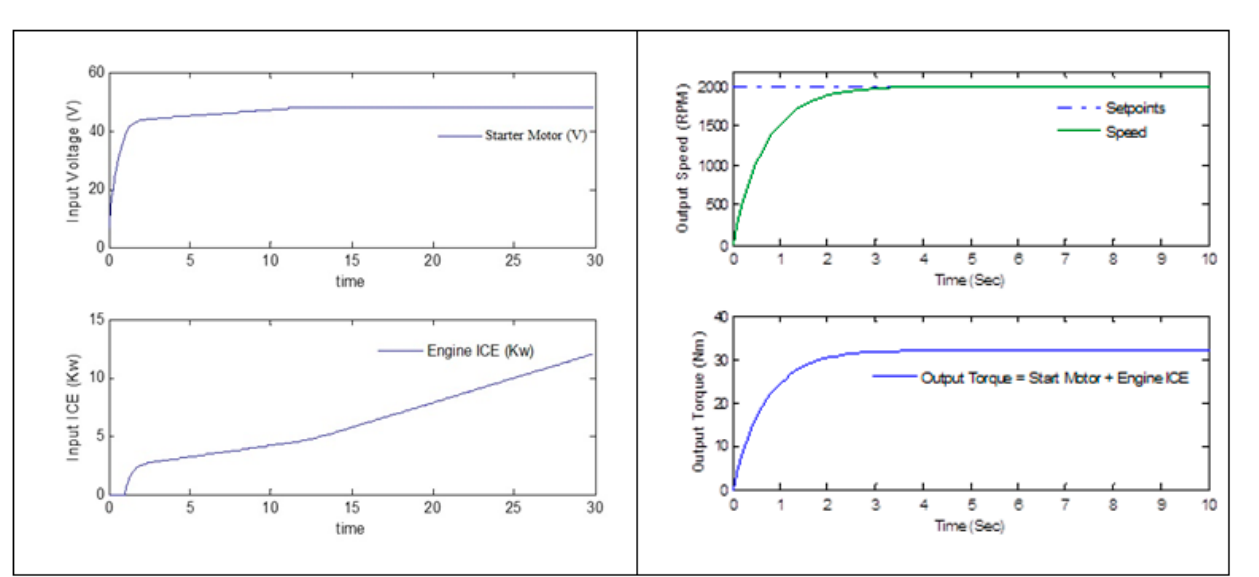
Figure 8. The MPC for the HEV with ICE and ME2.